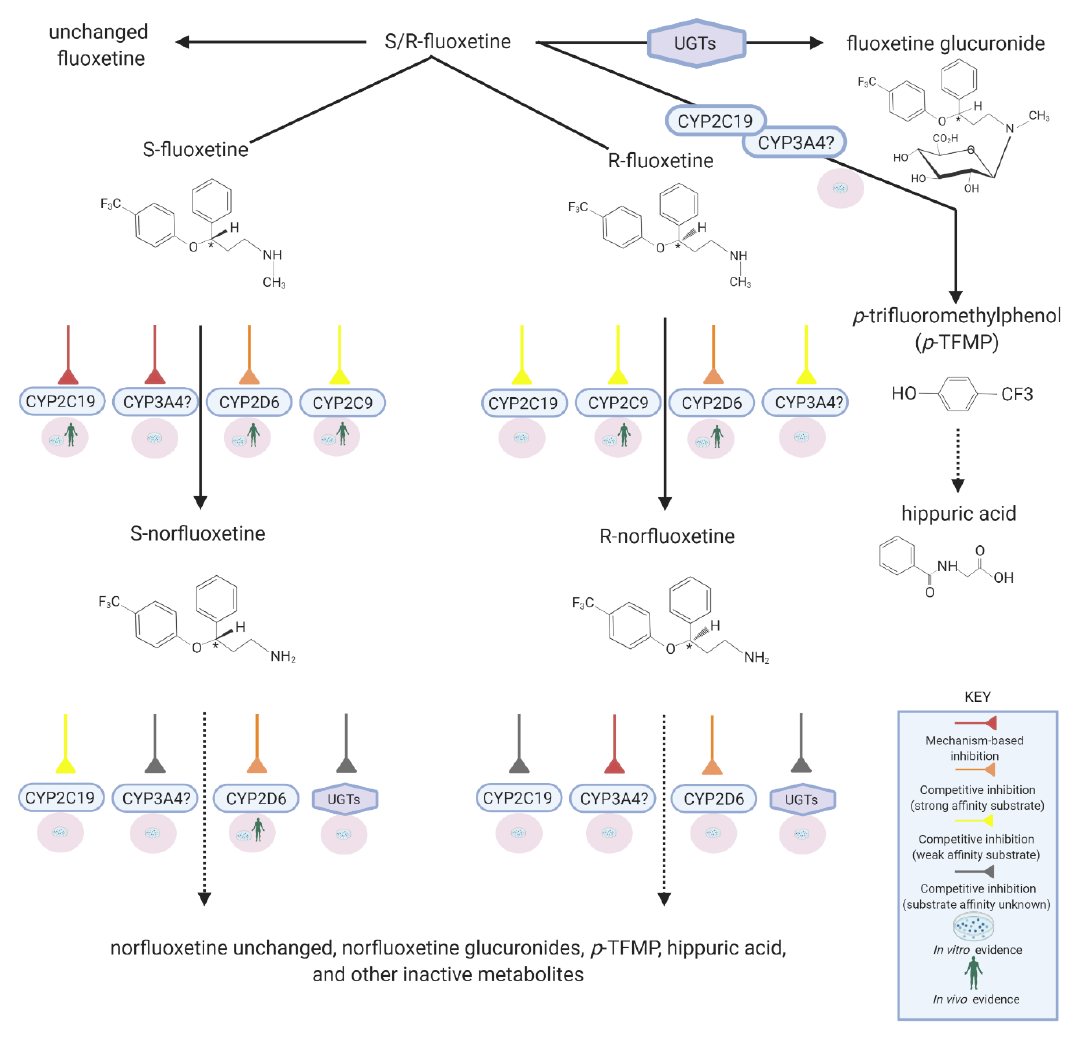
Figure 1. Disposition pathways of fluoxetine. Created with BioRender.com